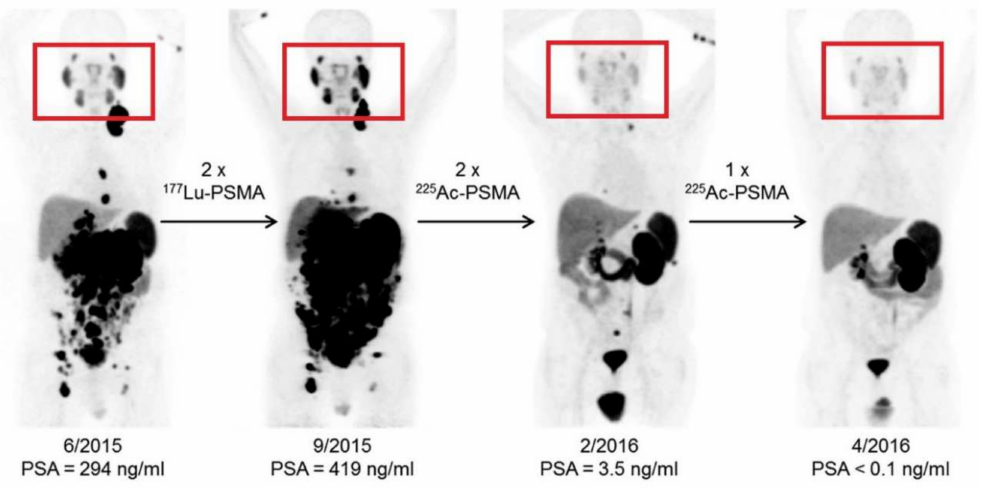
Figure 2. The effect of [ 225 Ac]Ac-PSMA-617 treatment on salivary glands compared to [ 177 Lu]Lu- PSMA-617 treatment (this research was originally published in JNM. Kratochwil et al. [46], 225 Ac- PSMA-617 for PSMA targeted α -radiation therapy of metastatic castration-resistant prostate cancer. J. Nucl. Med. 2016 , 57 (12),